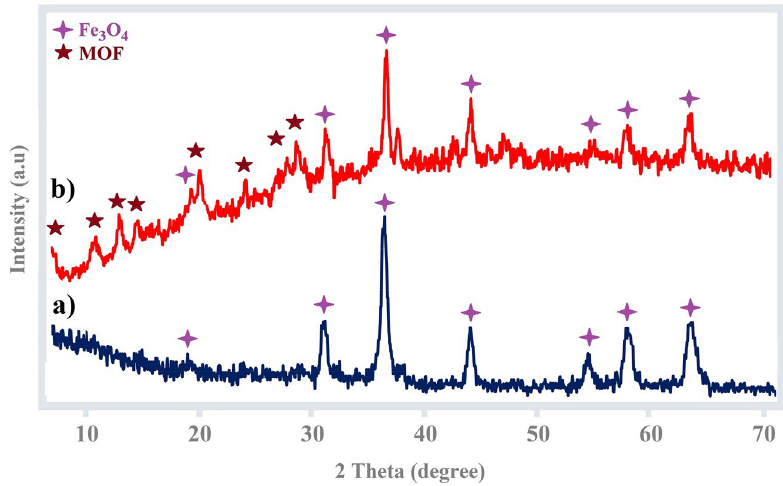
Figure 8. XRD pattern of ( a ) Fe 3 O 4 and ( b ) Fe 3 O 4 @HKUST-1.